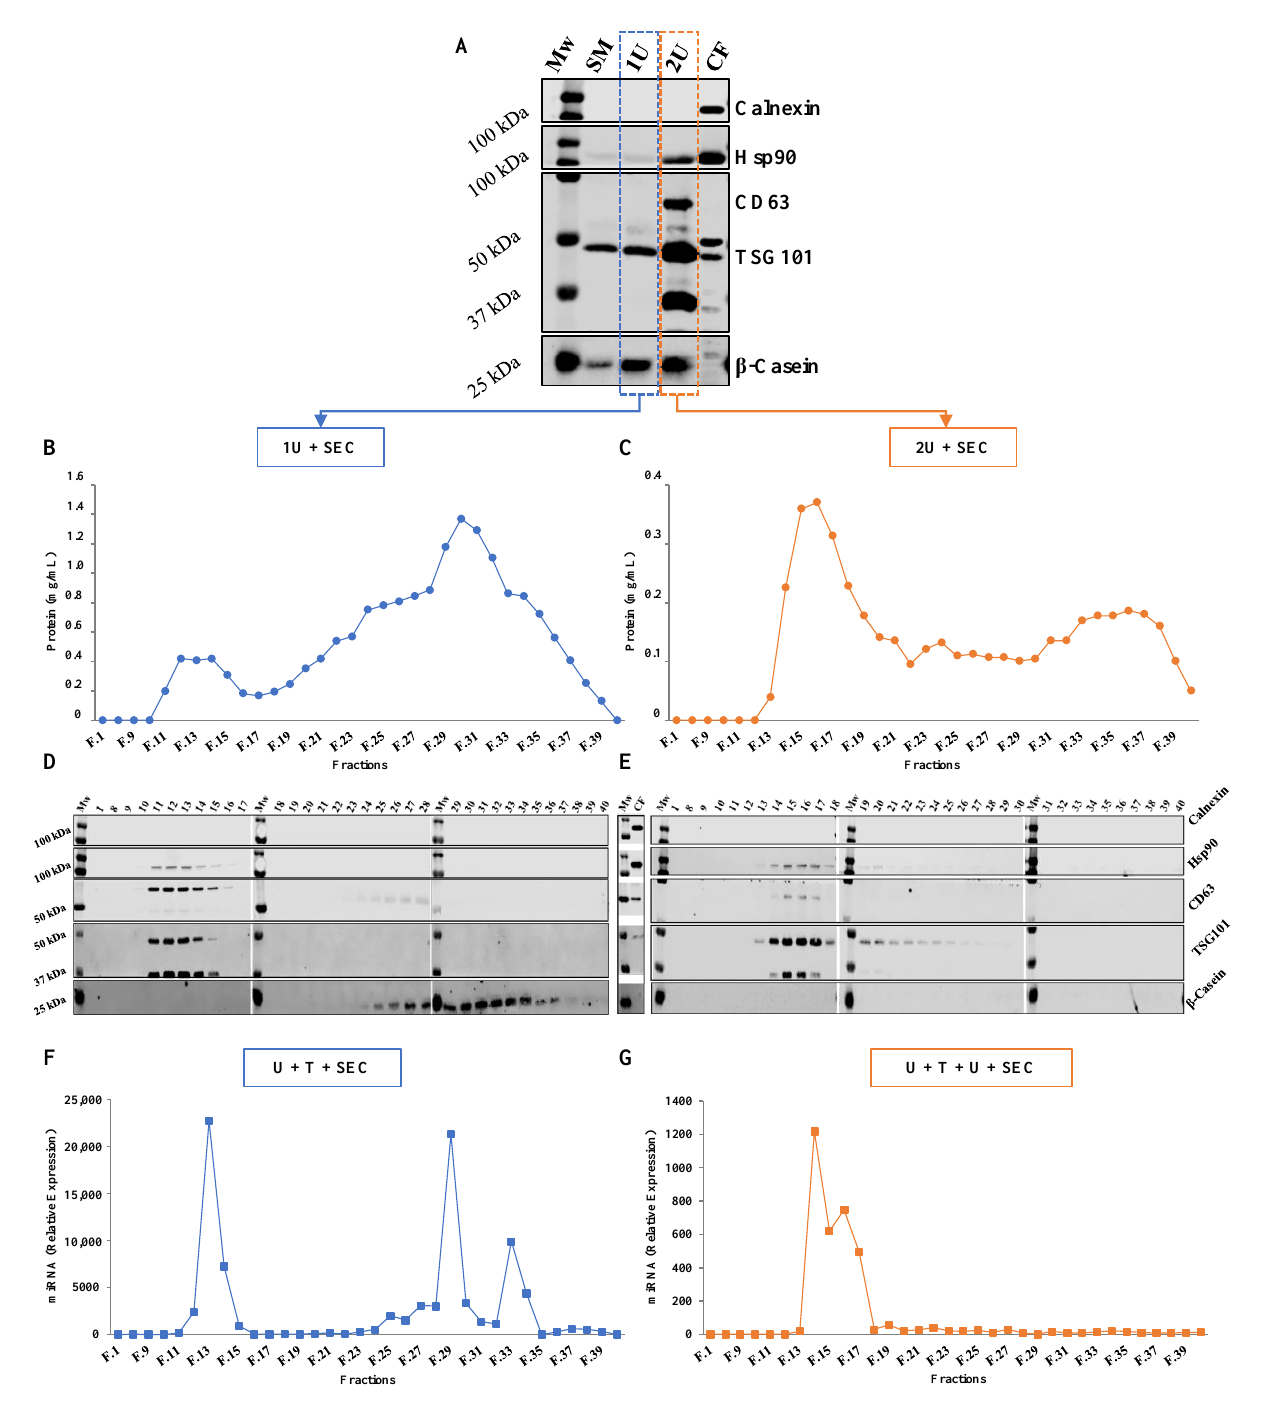
Figure 1. ( A ) Western Blot analysis of proteins present (Hsp90, CD63 and TSG101) or absent (calnexin) in exosomes and abundant in bovine milk ( β -casein). Protein evaluation in: bovine skimmed milk (SM); exosomes obtained from SM by one (1U) or two (2U) ultracentrifugation steps; and the cellular fraction (CF). Equal amount of protein was loaded. Elution protein profile (F.1, F.8 to F.40) of bovine exosomes isolated by 1U followed by SEC (1U + SEC) ( B ) or 2U + SEC ( C ). Protein concentration (mg/mL) was estimated by the BCA assay. WB of SEC elution fractions from exosomes isolated by 1U + SEC ( D ) or 2U + SEC ( E ). Evaluation of Hsp90, CD63, TSG101, Calnexin and β -casein levels in each fraction (F.1, F.8 to F.40). Mimic hsa-miRNA-148a-3p elution profile (relative expression) of exosomes isolated from skimmed milk by U + T + SEC ( F ) or U + T + U + SEC ( G ). Mw: Molecular weight marker